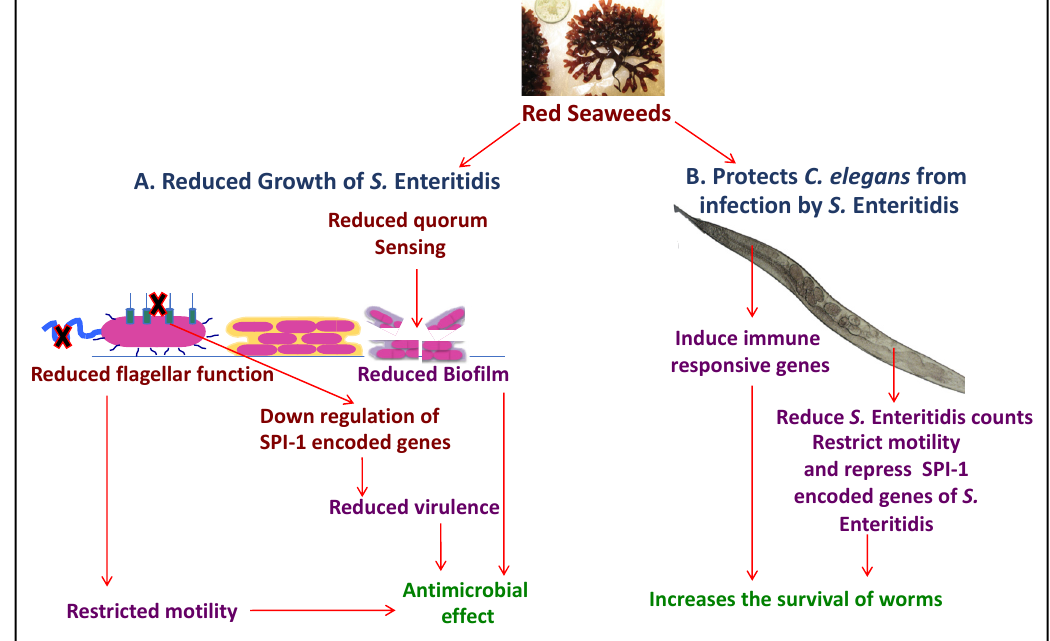
Figure 3. Illustration of modes of actions of selected red seaweeds, Chondrus crispus (CC) and Sarcodiotheca gaudichaudii (SG). A. Direct anti-microbial effect: red algal extracts inhibited growth, motility, biofilm formation and quorum sensing mechanisms in Salmonella Enteritidis. B. Protection of Caenorhabditis elegans from infection by S. Enteritidis: both red seaweed extracts increased the survival of infected worms by reducing S. Enteritidis colonization in Caenorhabditis elegans and enhancing the immune response of the worms (redesigned from [89]).